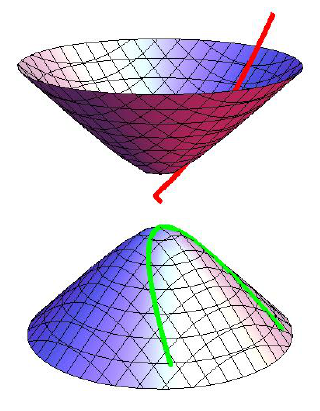
Figure 4. r (red) and ¯ r (green) on H 2